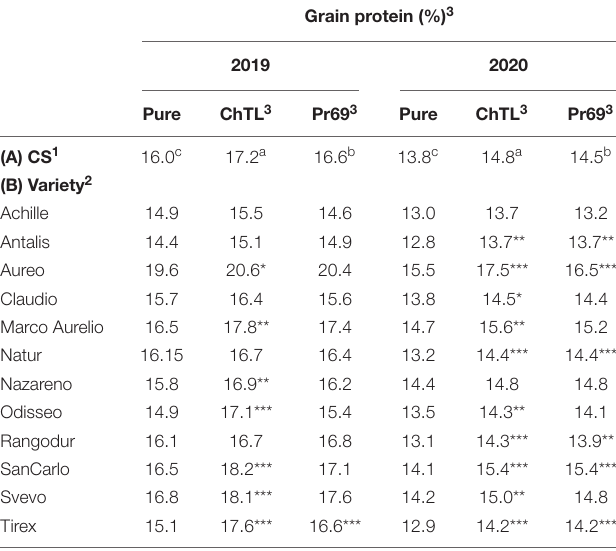
TABLE 5 | Durum wheat grain protein content (%) in 2019 and 2020. Grain protein (%)